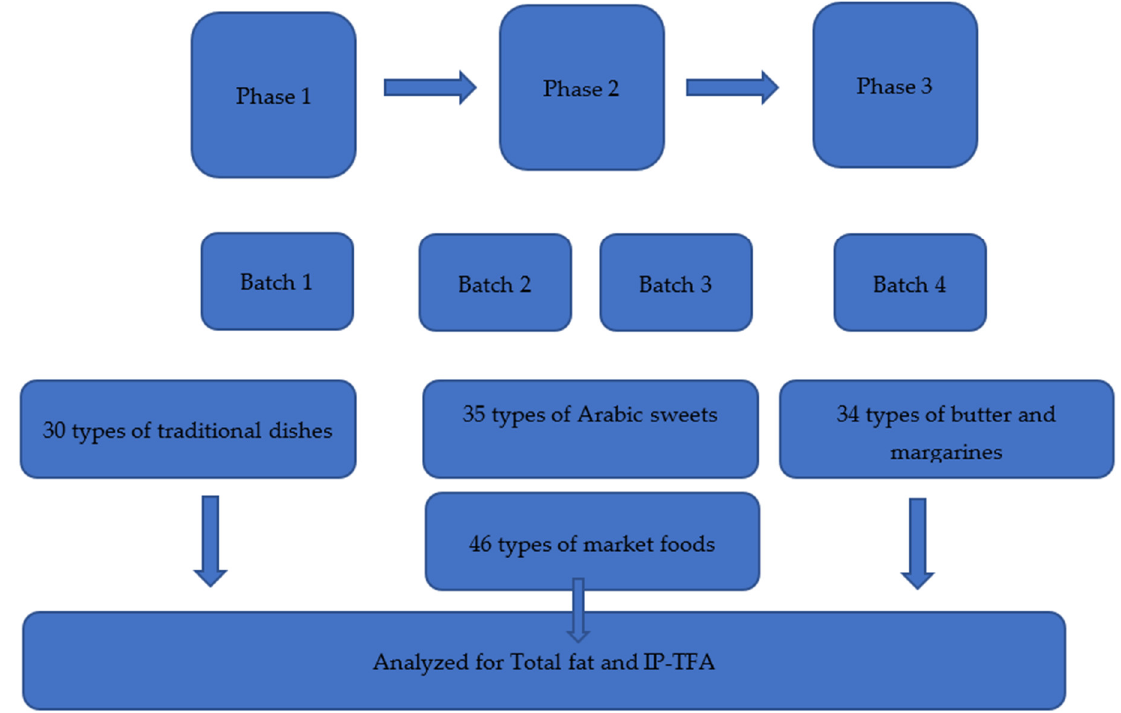
Figure 1. Graphical scheme of the current study.